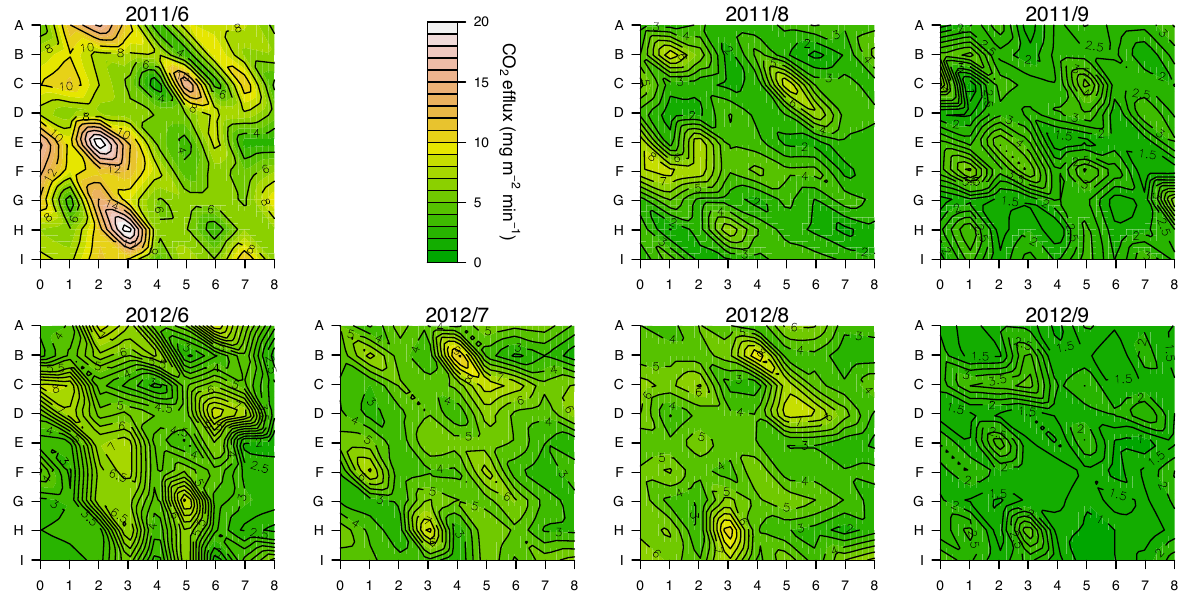
Figure 2. Spatial distribution of CO 2 efflux (mgCO 2 m − 2 min − 1 ) within a 40m × 40m plot (5m interval; 81 points) in Council, Seward Peninsula, Alaska during the growing seasons of 2011 (upper panel) and 2012 (lower). Due to heavy rain in early July 2011, this data could not be measured, as shown in Fig.